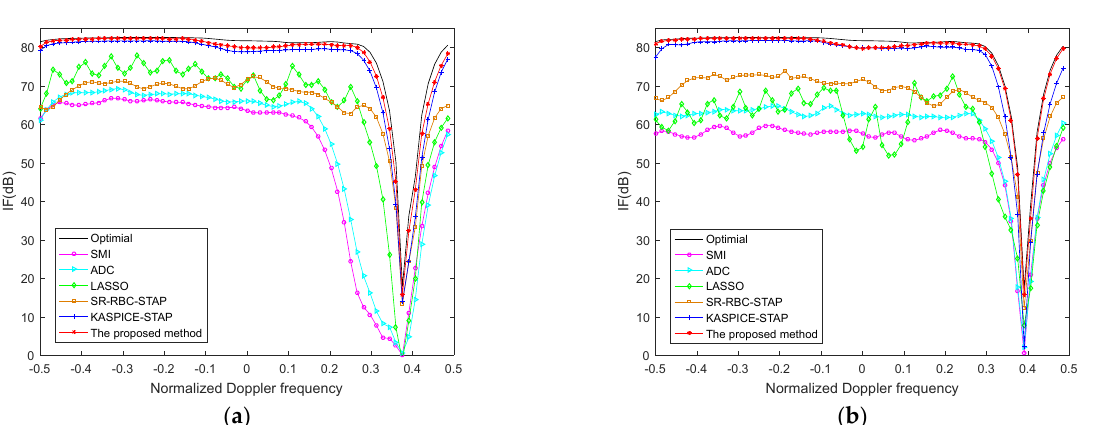
Figure 3. Clutter Angle ‐ Doppler spectrums estimated by different methods in the ideal condition: ( a ) ideal CNCM; ( b ) SMI; ( c ) KASPICE ‐ STAP; ( d ) the proposed method. Figure 4 exhibits the IF curves which are the IF versus normalized Doppler frequency with various methods in the 300th and 500th range cells. The number of training samples is chosen as 2 NM in SMI, ADC, and SR ‐ RBC methods. The number of iterations in KASPICE ‐ STAP method is set to 5. The user parameter in the LASSO method is set to 0.001. The number of iterations in the proposed KA ‐ MSLIM ‐ STAP method is 5. The KA ‐ MSLIM ‐ STAP will show good performance.